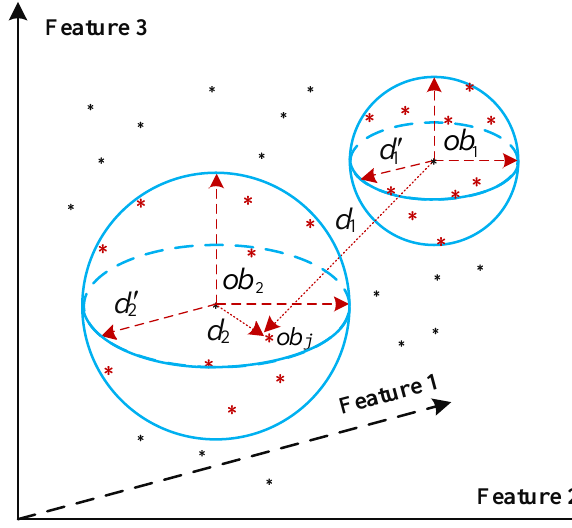
Figure 3. Reachability distance of objects in three-dimensional feature space.